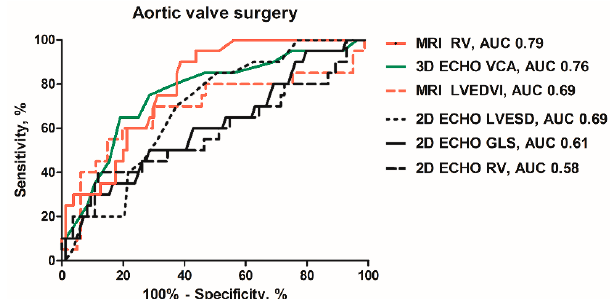
Figure 2. Receiver-operating characteristics curves of the MRI-derived: regurgitant volume (RV) and left ventricular end-diastolic volume index (LVEDVI); the 3D ECHO-derived: vena contracta area (VCA); 2D ECHO-derived: left ventricular end-systolic diameter (LVESD); RV and global longitudinal strain (GLS) to predict AV surgery.